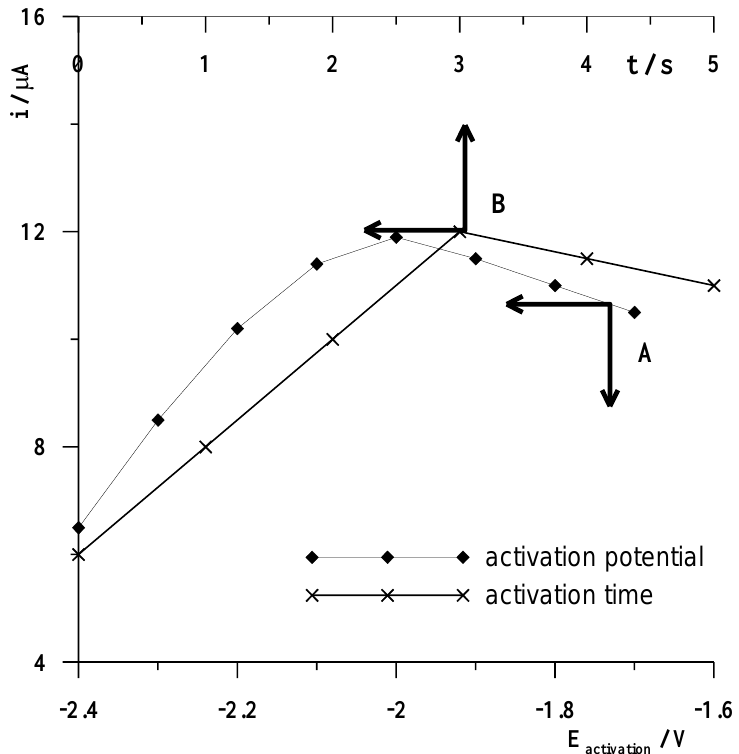
Figure 5. The influence of activation potential at a constant activation time of 3 s ( A ) and activation time at a constant activation potential of − 2 V ( B ) on the voltammetric signal of 5 × 10 − 8 mol L − 1 Cd(II). Concentrations of 0.1 mol L − 1 acetate buffer at pH = 3 ± 0.1 and 1.5 × 10 − 4 mol L − 1 Bi(III).